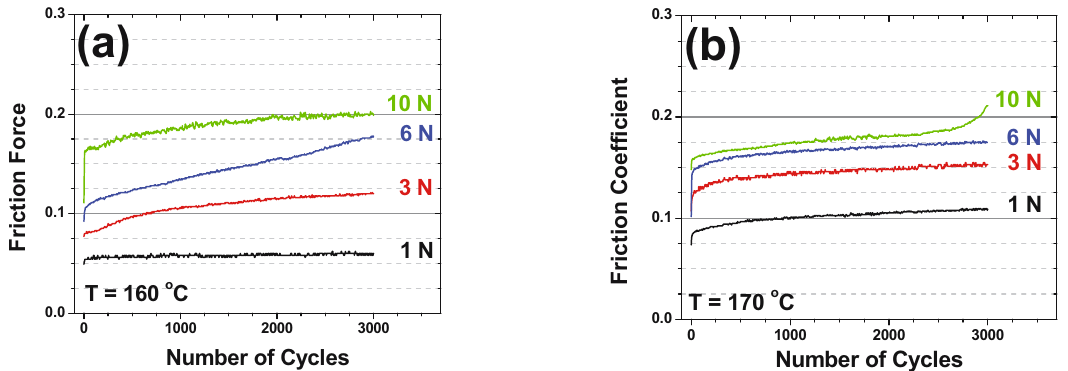
Figure 7: Friction coe ffi cient versus the number of cycles at di ff erent loads for samples made at ( a ) 160°C and ( b ) 170°C. The wear track is parallel to the textured lines of the